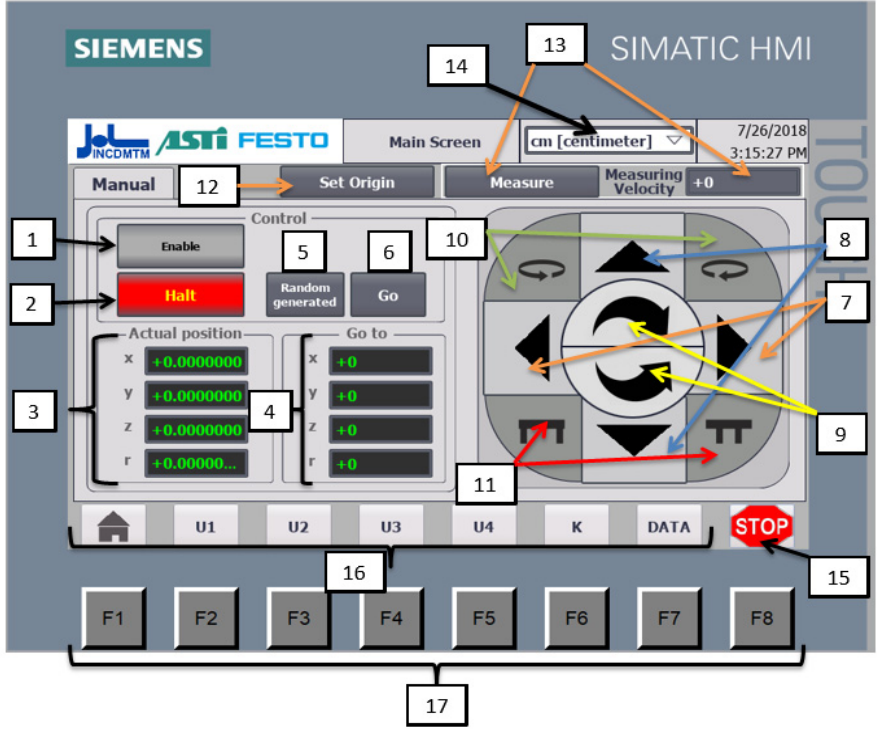
Figure 13. MMI4D system command and control panel.